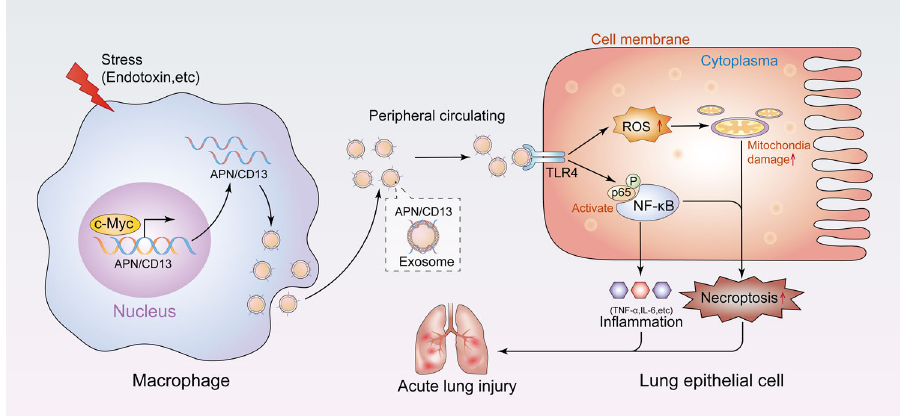
Fig. 8 Working model. Our data demonstrated that c-Myc directly induces APN/CD13 expression in LPS-stimulated macrophages, which promotes APN/ CD13 secretion into exosomes. In addition, we found that exosomal APN/CD13 from macrophages regulates the necroptosis of epithelial cells by binding to the cell surface receptor TLR4, enhancing NF- κ B activity and mitochondrial dysfunction, and promoting RIPK1/RIPK3 necroptosis. In conclusion, our fi ndings reveal that the communication between macrophages and lung epithelial cells via exosomal APN/CD13 leads to mitochondrial dysfunction, augments in fl ammation and increases cell apoptosis, so that participates in the occurrence of sepsis-induced